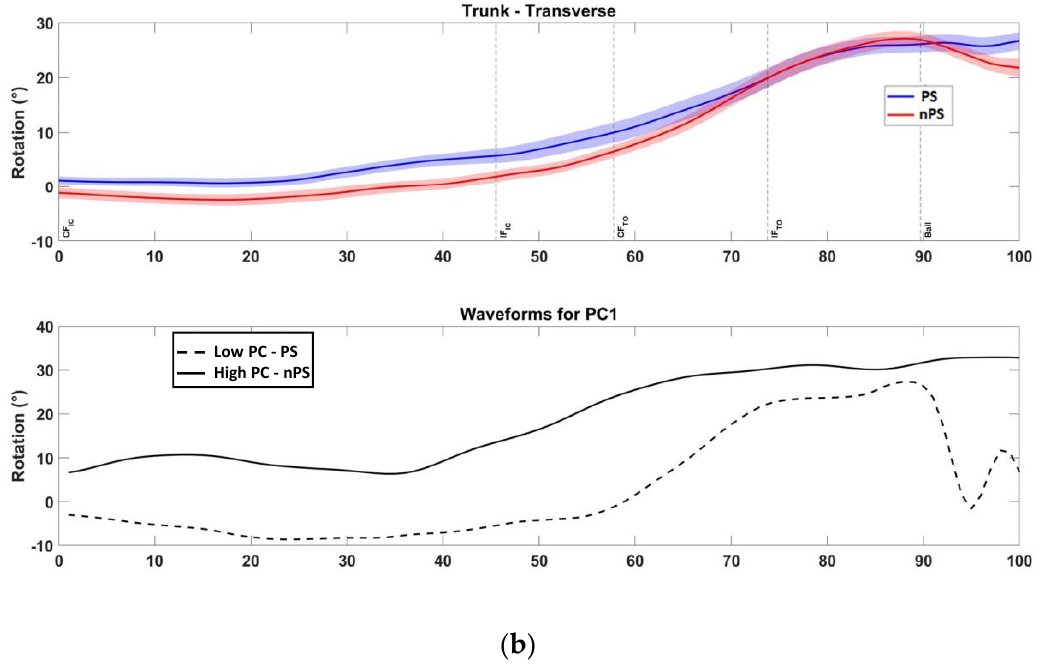
Figure A5. LOW DIVE—Pelvis/Trunk/Head: ( a ) in the bottom row, preferred side waveform is represented by the low PC (dashed line) for this kinematic variable; ( b ) in the bottom row, preferred side waveform is represented by the low PC (dashed line) for this kinematic variable. Note: PS=preferred diving side; nPS=non-preferred diving side; PC=principal component; IC=initial contact; TO=toe-off, CF=contralateral foot; IF=ipsilateral foot; Ball=ball contact.